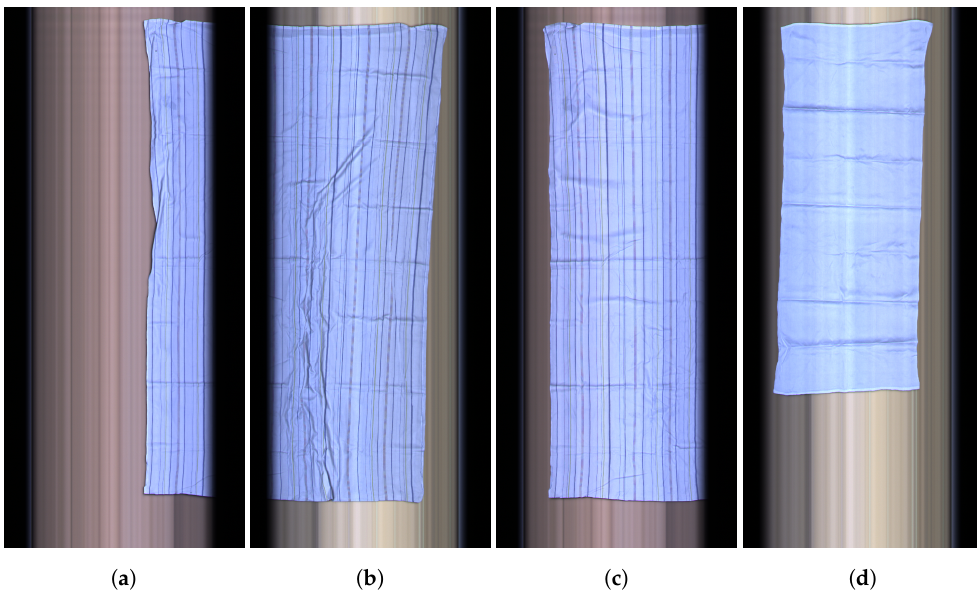
Figure 2. A few example images from our dataset. From left to right: An image acquired by the camera on the left ( a ). The corresponding image acquired by the camera on the right ( b ). An image of the same piece of laundry shifted further to the left ( c ). An image of a small piece of laundry fitting into the scope of a single camera ( d